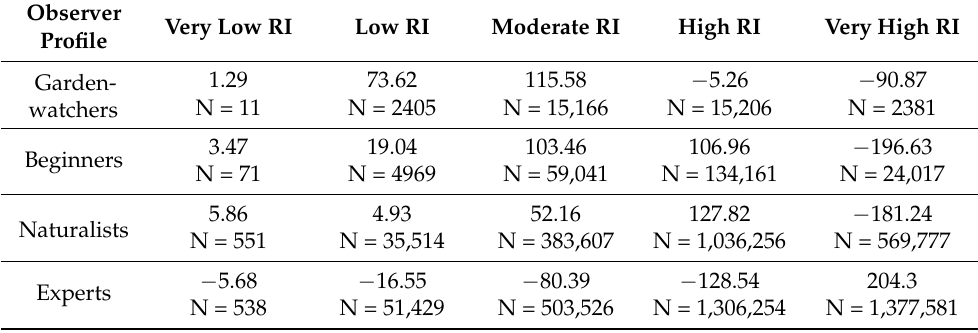
Table A5. Pearson residuals from the Chi 2 test of homogeneous distribution of